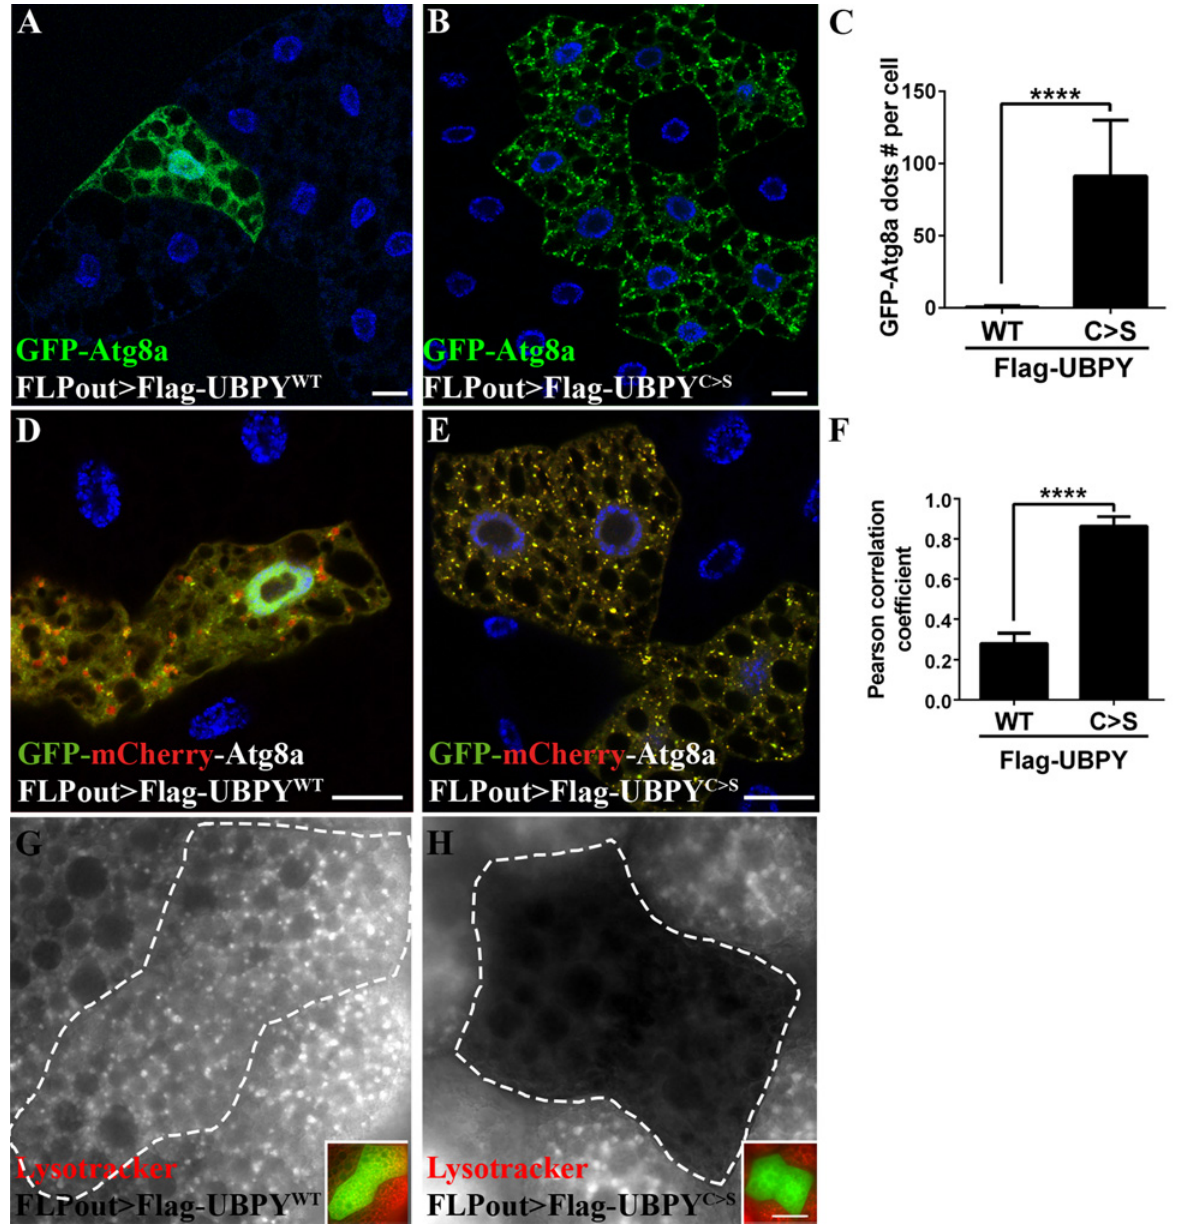
Fig 3. Expression of a catalytic inactive UBPY mutant blocks the autophagy flux. Expression of the wild-type form of UBPY has no effect on autophagy (Flag-UBPY WT , A) whereas the UBPY catalytic mutant form induces accumulation of GFP-Atg8a dots (Flag-UBPY C > S , B). Quantification of the number of GFP-Atg8a dots per cell is show in C. Confocal sections of larval fat bodies expressing the GFP-mCherry-Atg8a in combination with the wild-type (D) or catalytic inactive (E) forms of UBPY. Please note that the expressing the wild-type form of UBPY (D) were starved to induce autophagy and allow the observation of autophagosomes. (F) Quantification of the colocalization of mCherry and GFP signals using the Pearson ’ s correlation coefficient. Larvae expressing the wild-type (G) or the mutant (H) form of UBPY were starved to induce autophagy and stained with Lysotracker Red. Insets show the merged channels of the respective images and the clone boundaries are indicated as dotted lines. Scale bars: 20 μ m. N > 6 larvae per experimental condition. For quantification, bars denote mean ± s.d. Statistical significance was determined using one-way ANOVA : **** p < 0.0001, ns: not significant. Genotypes: (A, G) y w hs-FLP/+; UAS-GFP-Atg8a/+; Ac > CD2 > Gal4/UAS-2xFlag-UBPY WT , (B, H) y w hs-FLP/+; UAS-GFP-Atg8a/+; Ac > CD2 > Gal4/ UAS-2xFlag-UBPY C > S , (D) y w hs-FLP/+; UAS-GFP-mCherry-Atg8a/+; Ac > CD2 > Gal4/UAS-2xFlag-UBPY WT , (E) y w hs-FLP/+; UAS-GFP-mCherry-Atg8a/+ , ; Ac > CD2 > Gal4/ UAS-2xFlag-UBPY C > S .